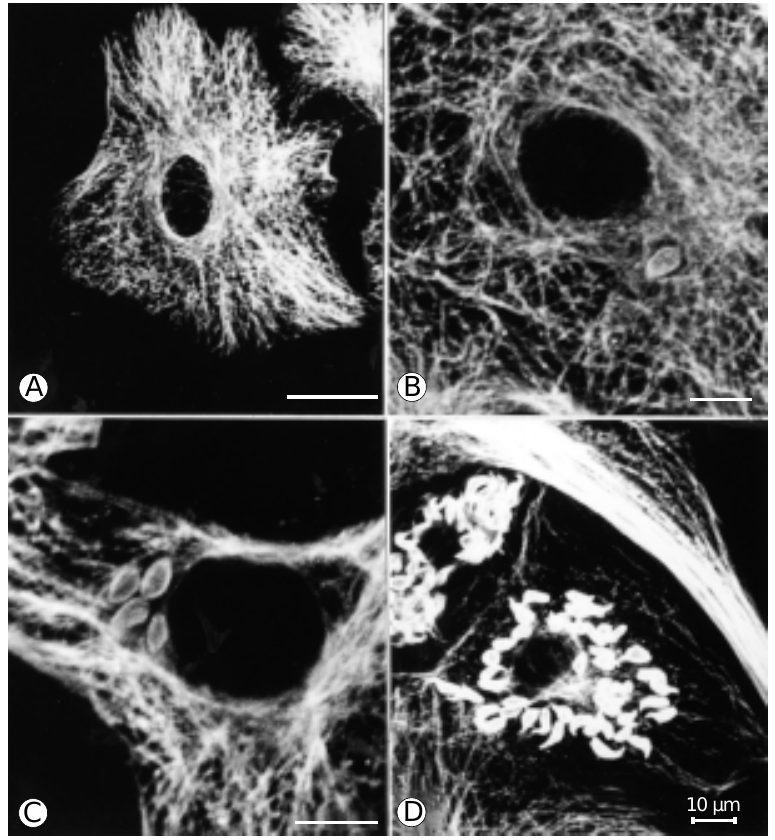
Figure 8 - Distribution of microtubules visualized with anti-tubulin antibodies, in control cells (A) and cells infected with Trypanosoma cruzi after 24 (B), 48 (C) and 72 (D) h. A : Bar = 25 µm; B - D : Bar = 10